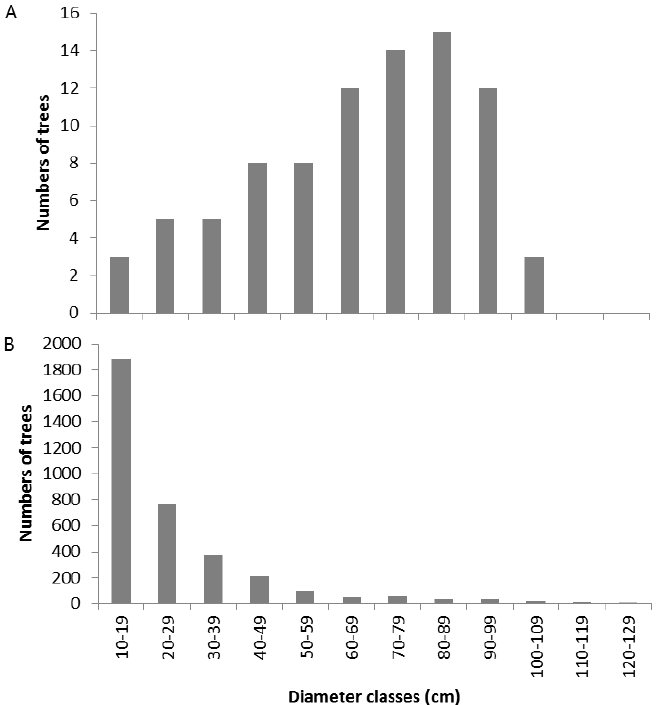
Figure 4. Population structure of P. elata ( A ) and all of the species ( B ) individuals recorded in the botanical sampling plots installed in all sites and zones. The absolute number of trees is given by diameter